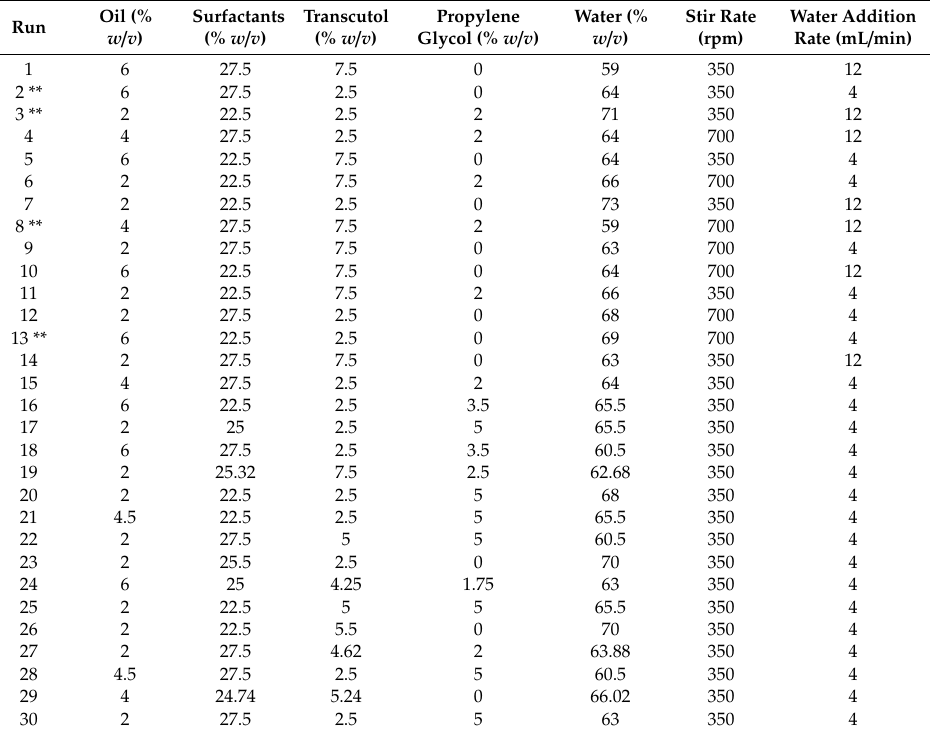
Table 4. Runs in the design of